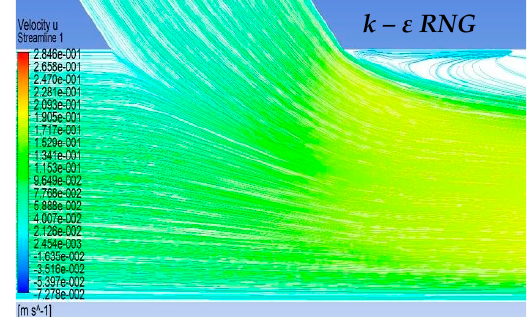
Table 2. Test case scenarios with calculation of velocities and Reynolds numbers.